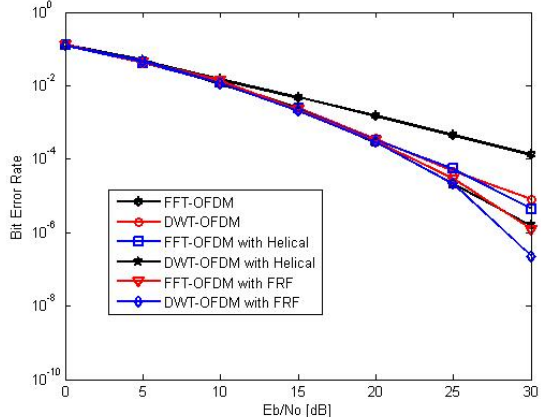
Figure 10. BER performance for the FFT − OFDM and DWT − OFDM systems over SUI-2 channel.